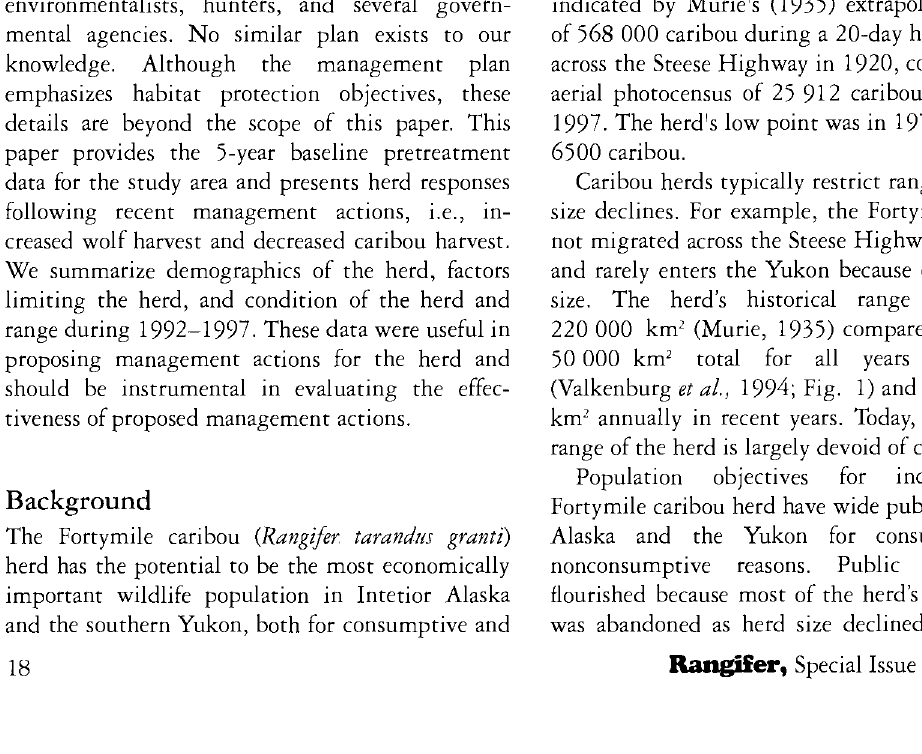
Fig. 1. Range of the Fortymile caribou herd, 1984-1997, and historic range during the 1920s. involved, representing Alaska and Yukon